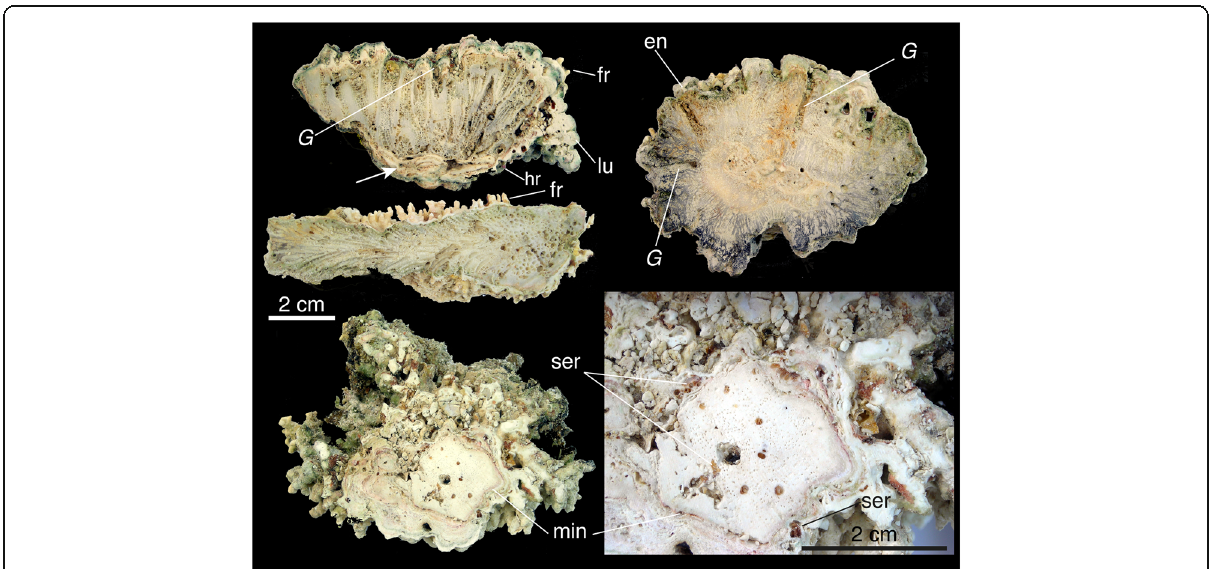
Fig. 4 Slab surfaces of Moorea algal nodules (< ~ 2 m water depth) showing encrusting (en) and fruticose (fr) coralline growth forms and the boring bivalve traces ( G , Gastrochaenolites ). Within the algal nodules, serpulids and encrusting/arborescent foraminifera (min, Miniacina ; hr, Homotrema ) are present. Note that most of the nodules consist of coral